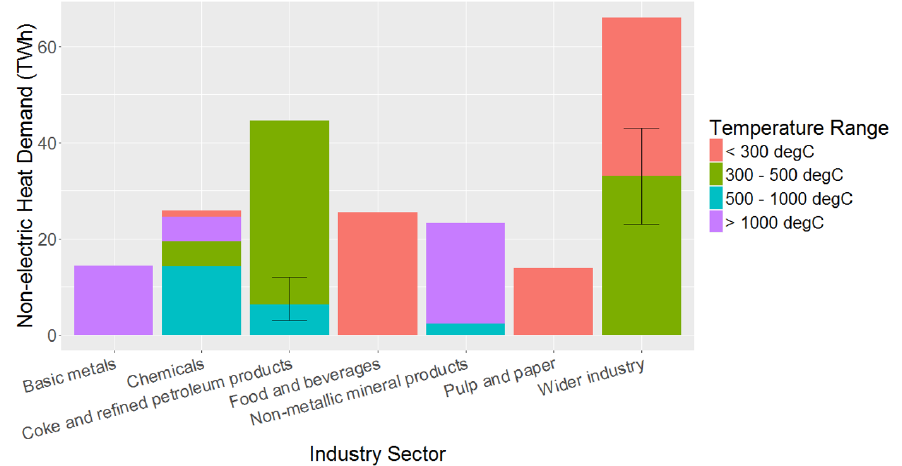
Figure 2. UK heat demand by temperature for non-electrically derived process heat. Error bars indicate uncertainty on the proportion of energy for a particular temperature range